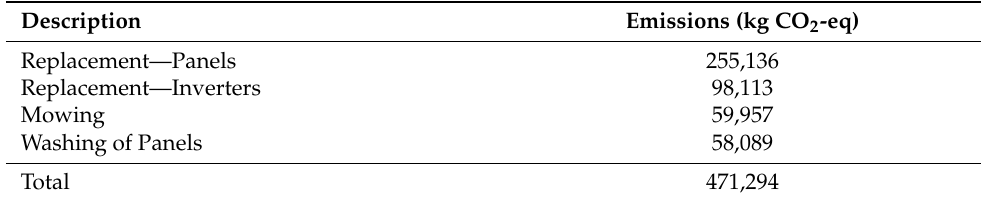
Table 9. GHG emissions for